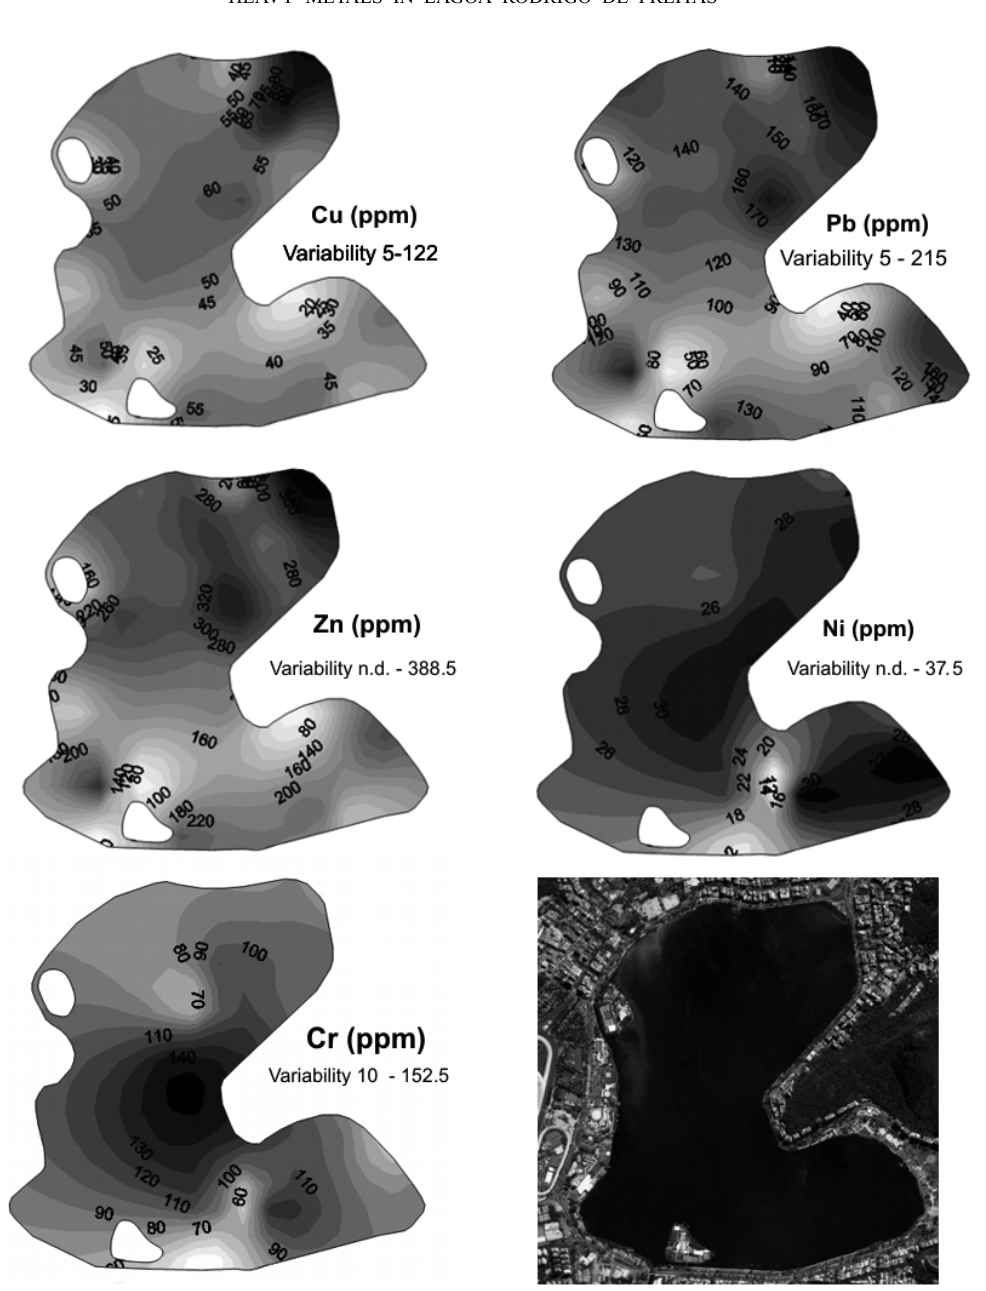
Fig. 2 – Heavy metal spatial variations during the first